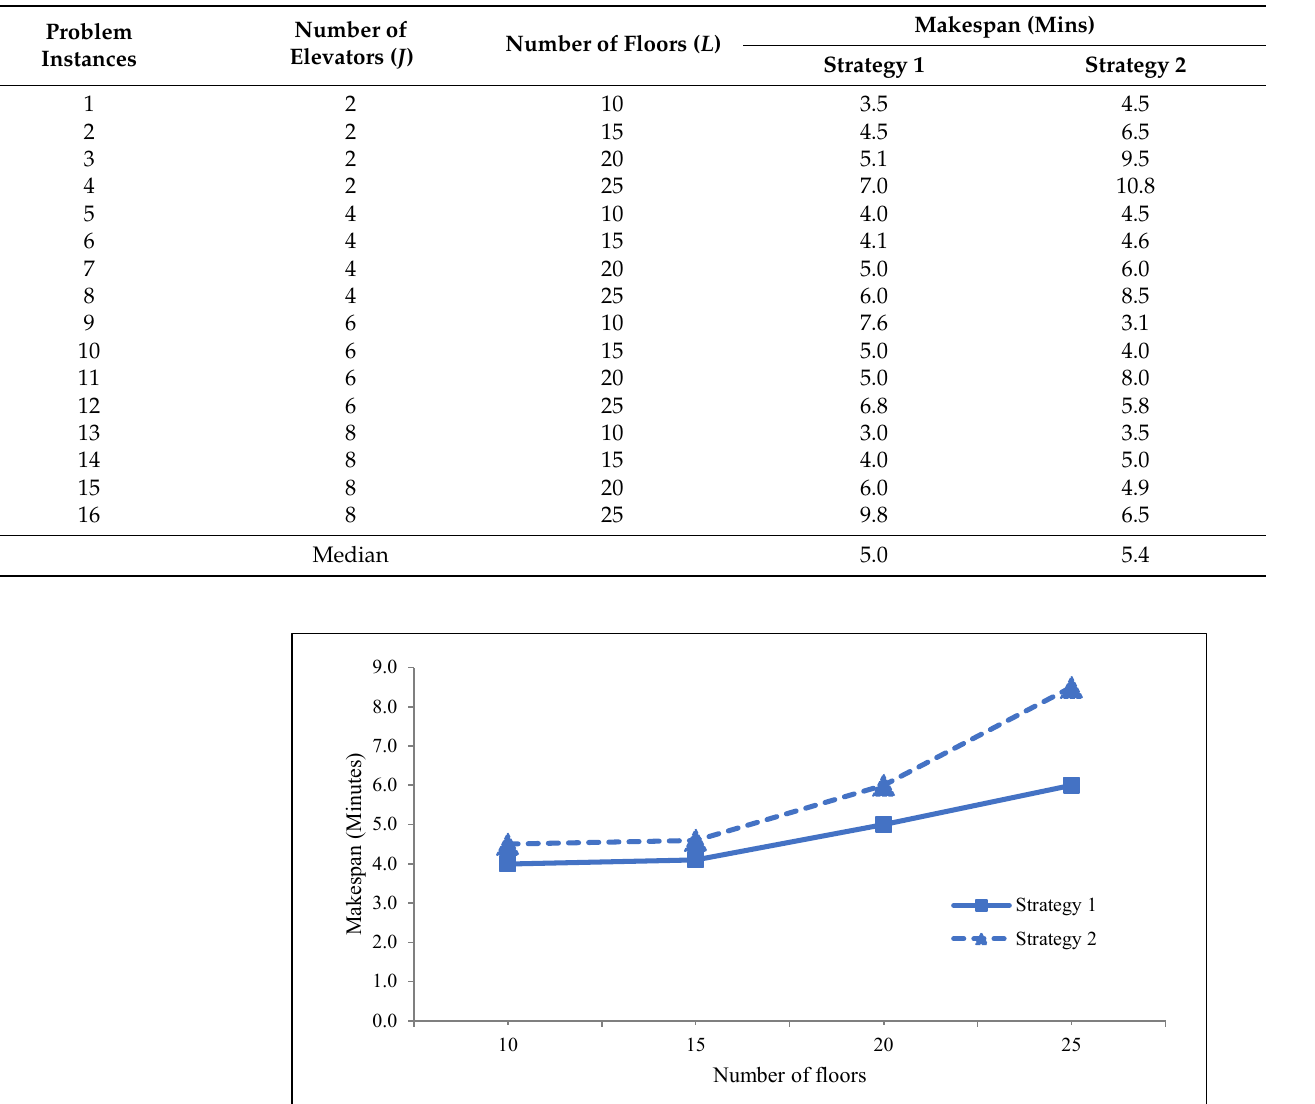
Table 5. Makespan for strategy 1 and 2 in different problem instances.